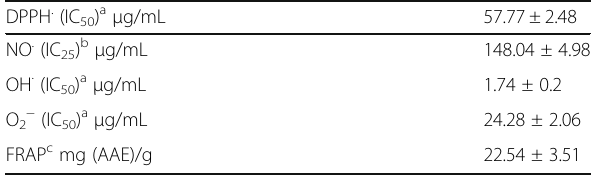
Table 3 Antioxidant activity of MG extract